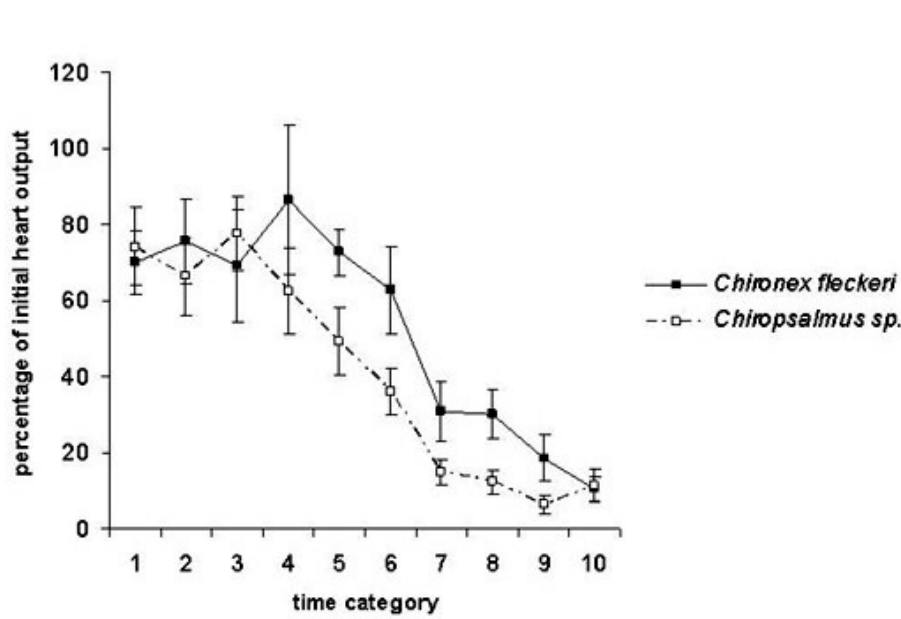
Figure 4: Percentage of initial heart output over time category for animals envenomed with Chironex fleckeri and Chiropsalmus sp. venom (95% confidence limits